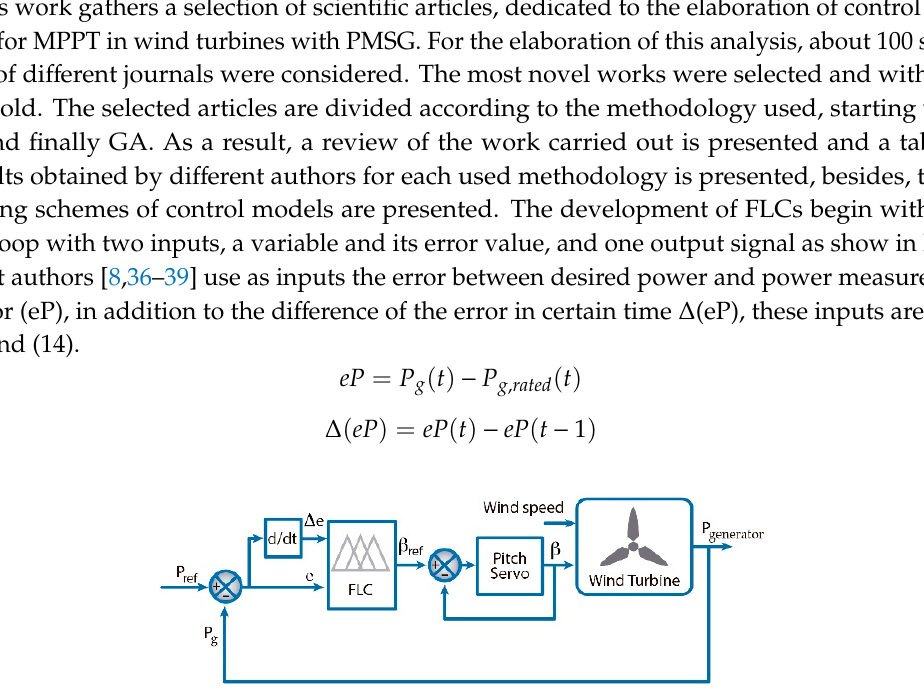
Figure 6. Basic scheme of fuzzy logic controller (FLC) for pitch angle [36–39].